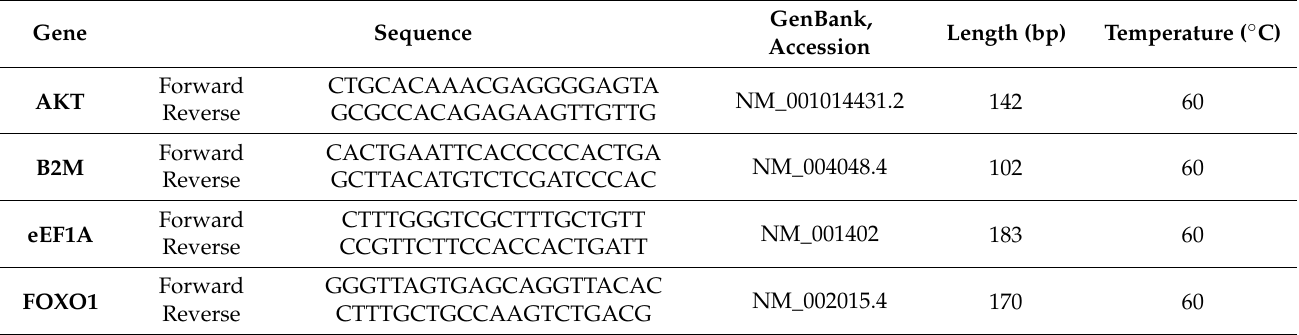
Table 3. Beta-2 Microglobulin (B2M); Eukaryotic translation elongation factor 1 alpha (eEF1A); Forkhead Box O1 (FOXO1); Myogenin (MYOG); Myosin heavy chain 2 (MYH2); Protein kinase B (AKT); Ribosomal protein L13a (RPL13A); Troponin T